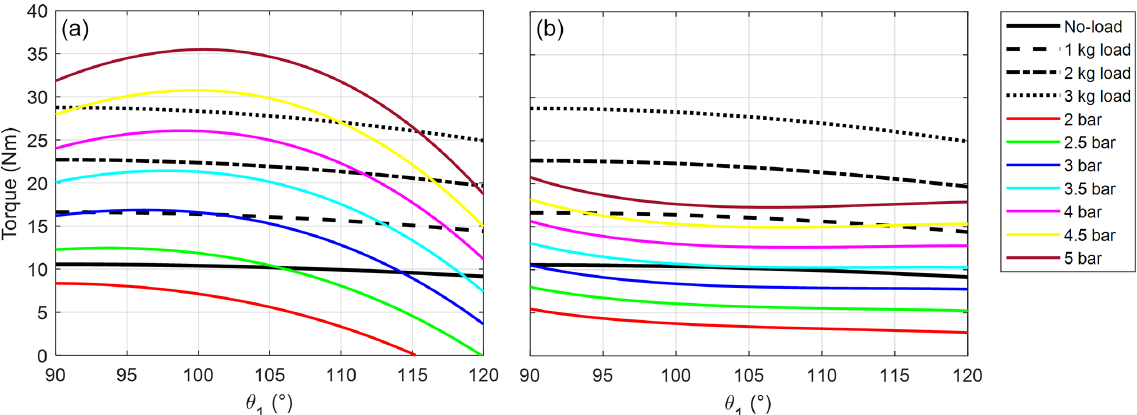
Figure 7. Gravitational torque in no-load (black line) and 1kg (dashed black line), 2kg (dot-dashed black line), and 3kg (dotted black line) loaded conditions as well as torque exerted by the exoskeleton (colored lines) at different supply pressures, by employing the DMSP-20- 200N muscle. The plot in (a) refers to the pulley-based design of the transmission system, while the plot in (b) refers to the cam-based design considering the theoretical optimal value of r i = 23 . 5mm.